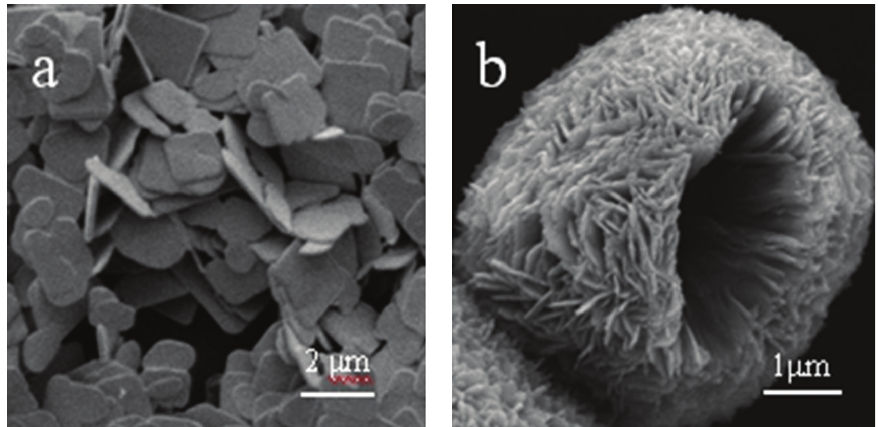
Figure 2: The SEM images of as-prepared BiOBr samples. (a) BiOBr-SB; (b) BiOBr-IL.